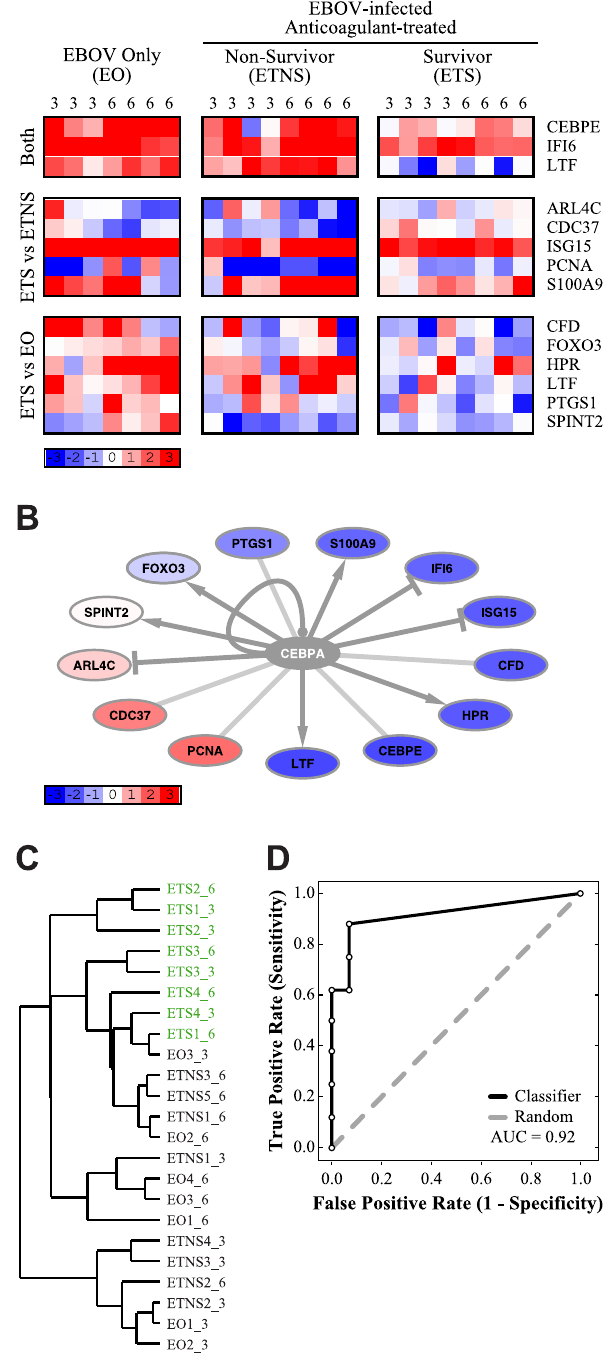
Figure 4. CCAAT/enhancer binding protein alpha (CEBPA)- regulated genes are down-regulated in NHPs that survive EBOV infection when compared to non-survivors. ( A ) A heatmap depicting the gene expression values of 14 probes (13 genes) which are transcriptionally regulated by CEBPA. The days post-infection are labeled at the top of each column. Probes are grouped according to which comparison identified them, listed to the left. Gene names are listed to the right. Blue indicates down-regulation, and red indicates up- regulation, of genes compared to pre-infection baseline, white indicates no change in expression (scale indicated). ( B ) A network illustrating transcriptional connections between the 14 genes and CEBPA.